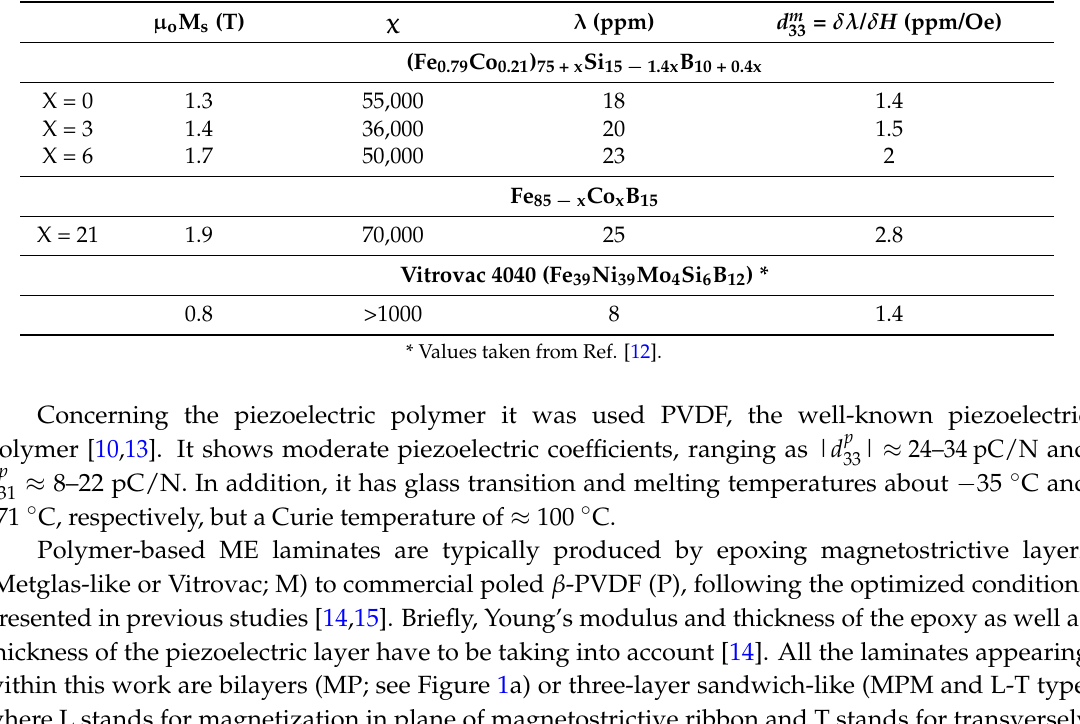
Table 1. Selected magnetic properties of the magnetostrictive sample compositions used in the fabrication of all ME laminates appearing in this